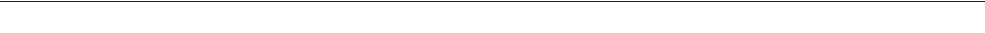
Fig. 6 KBU2046-mediated changes in the signature of client proteins bound to the HSP90 β /CDC37 heterocomplex mediate effects upon cell motility. a LUMIER assay. HEK293T cells were transfected with 1 of 420 different protein kinases, treated with 10 µ M KBU2046 ( N = 5 replicates) or vehicle control ( N = 5) for 3 days, and LUMIER assays performed. The N = 17 kinases that gave signi fi cant fi ndings (Student ’ s t -test <0.05) in the same direction in each of two separate experiments are depicted. Each separate treatment and kinase condition in each of two separate experiments was conducted in replicates of N = 5. b The experiment was then repeated for these 17 kinases in the presence of TGF β treatment, and those demonstrating signi fi cant differences ( t - test <0.05) in the same direction as in a are denoted by *. c , d Wound healing assay. PC3 cells were transfected with siRNA targeting RAF1 (si-Raf1) or non-targeting siRNA (si-control), treated with KBU2046 or vehicle as above, and RAF1 protein measured by western blot ( c ) and effects upon wound healing measured ( d ). e Inhibition of RAF1. Puri fi ed recombinant HSP90 β , CDC37, and RAF1 were combined with KBU2046, as indicated, incubated in an in vitro kinase assay for the indicated times, and western blot for RAF1-Ser 338 phosphorylation performed. f , g Effect on HSP90 β /CDC37 heterocomplex formation and function in vitro. Puri fi ed recombinant HSP90 β , CDC37, RAF1, SGK3, or MAP3K6 were combined and treated with KBU2046 or vehicle control, as indicated, incubated in an in vitro kinase assay for the indicated times, and western blot performed, as denoted. All experiments were repeated at separate times at least once, with similar